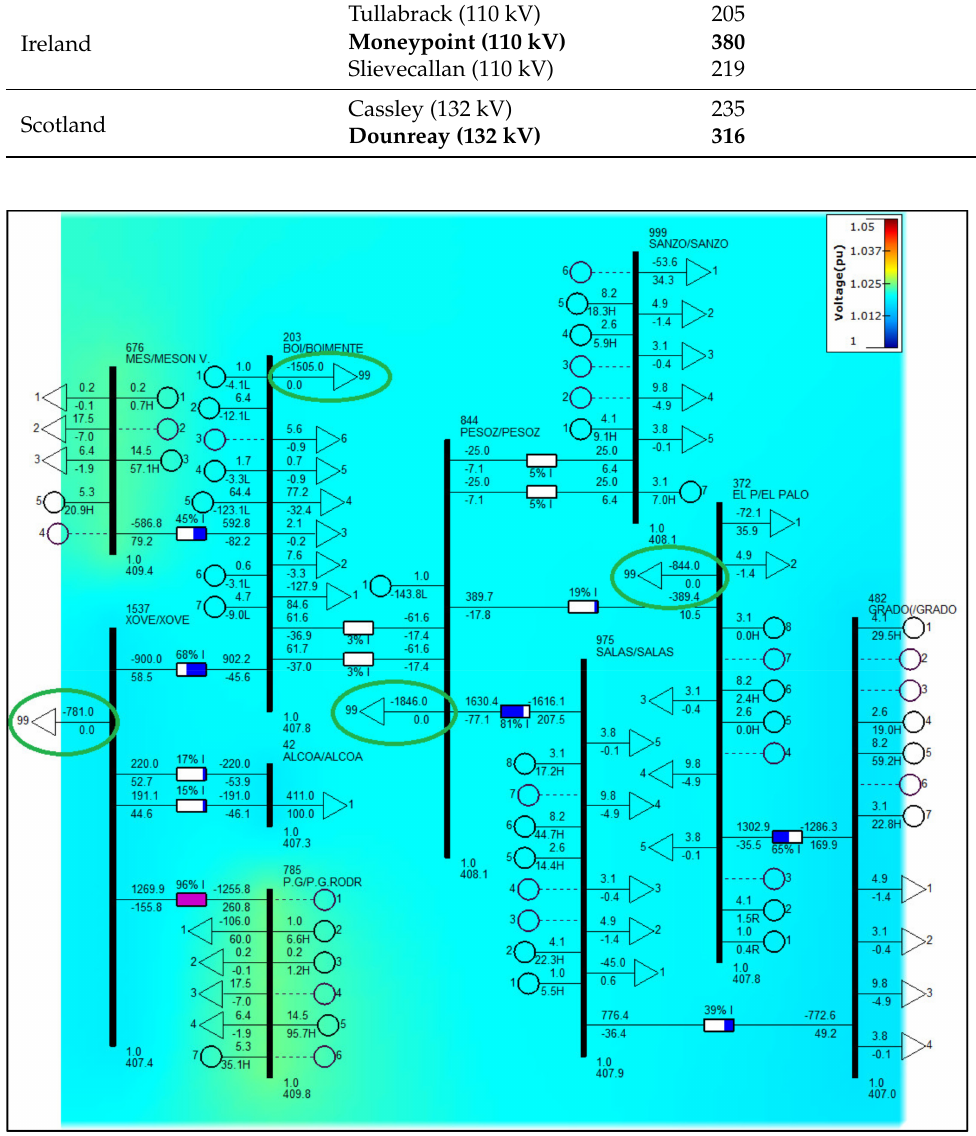
Figure 4. Nodal capacity calculation results for Spain (Ribadeo